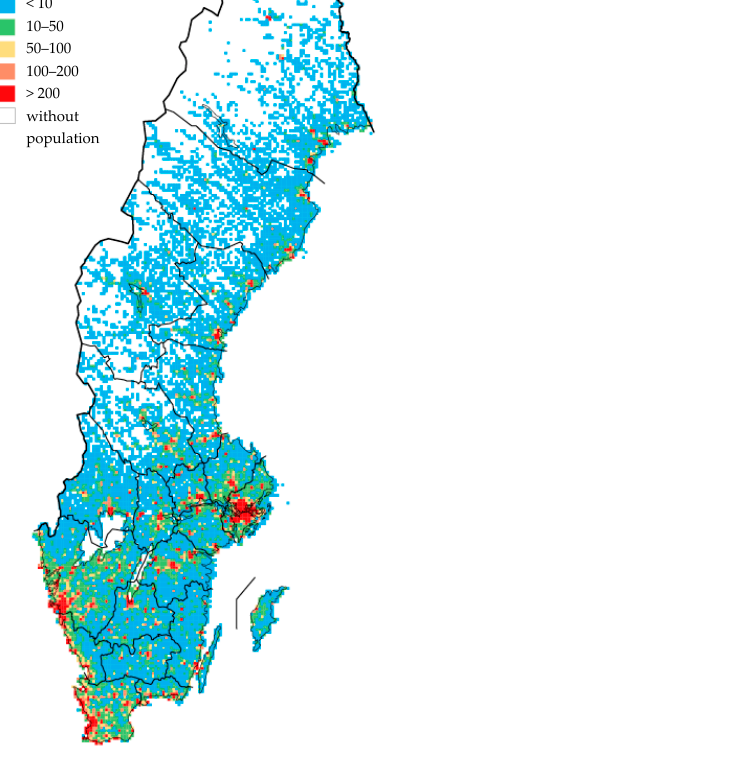
Figure 2 . Population density in Sweden according to Eurostat [72]. Figure 2. Population density in Sweden according to Eurostat